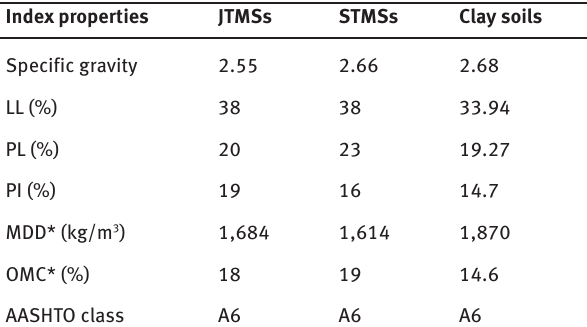
Table 2: Physical properties of TMSs samples and clay soils.